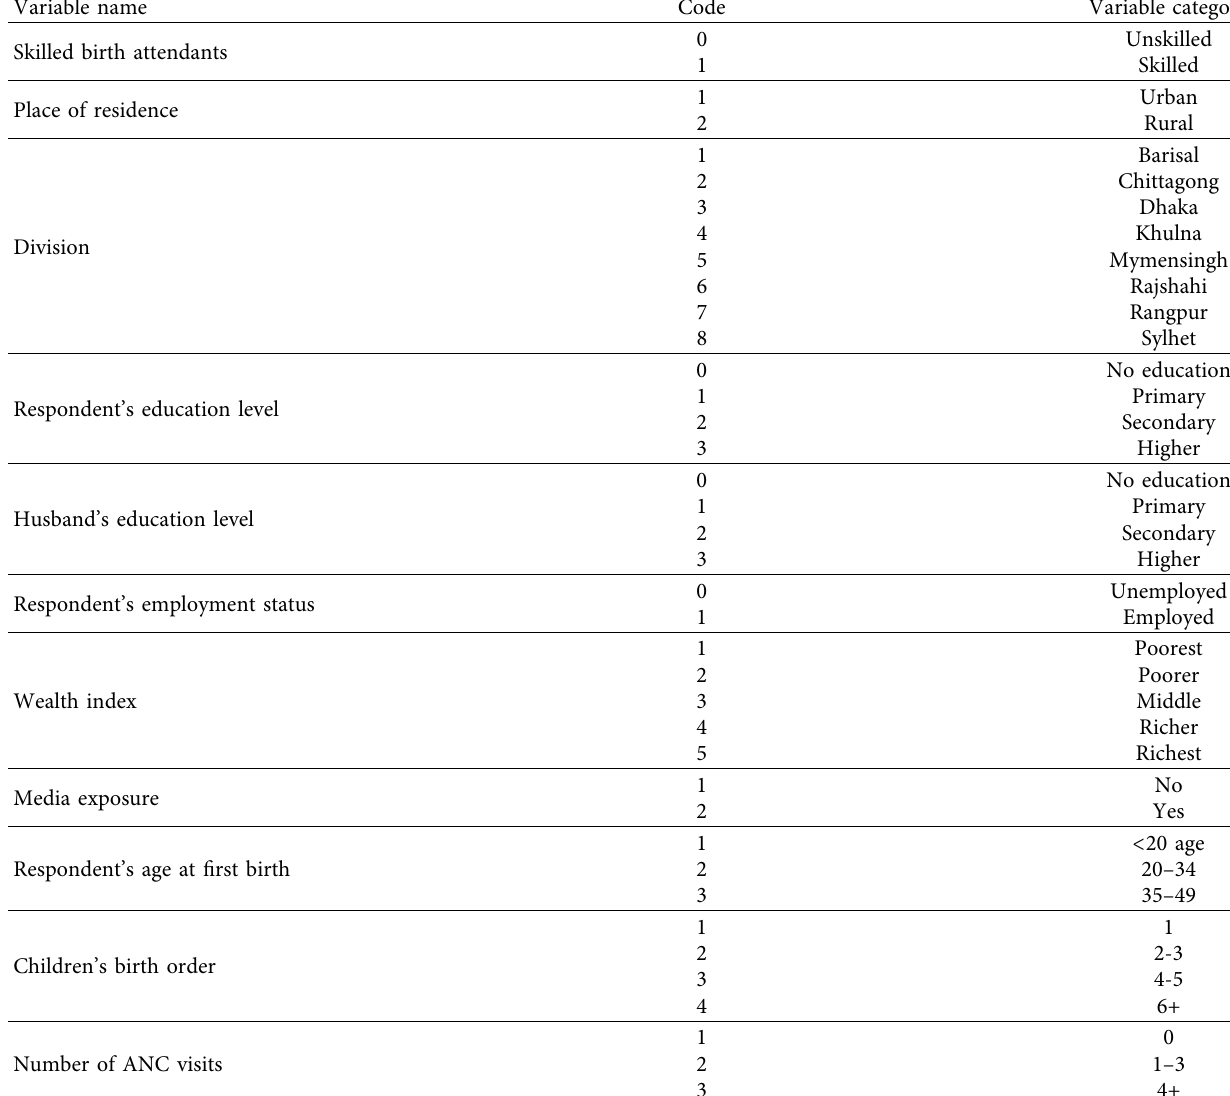
Table 1: Variable defnitions and coding for analysis.